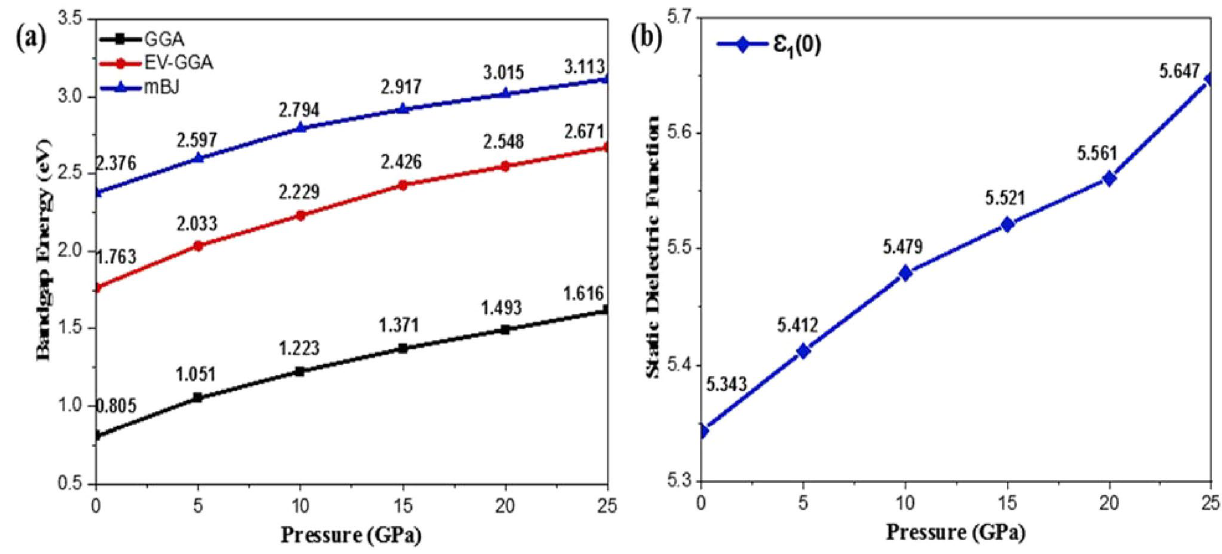
Figure 3. Pressure-induced variation in, ( a ) bandgap, and ( b ) static dielectric